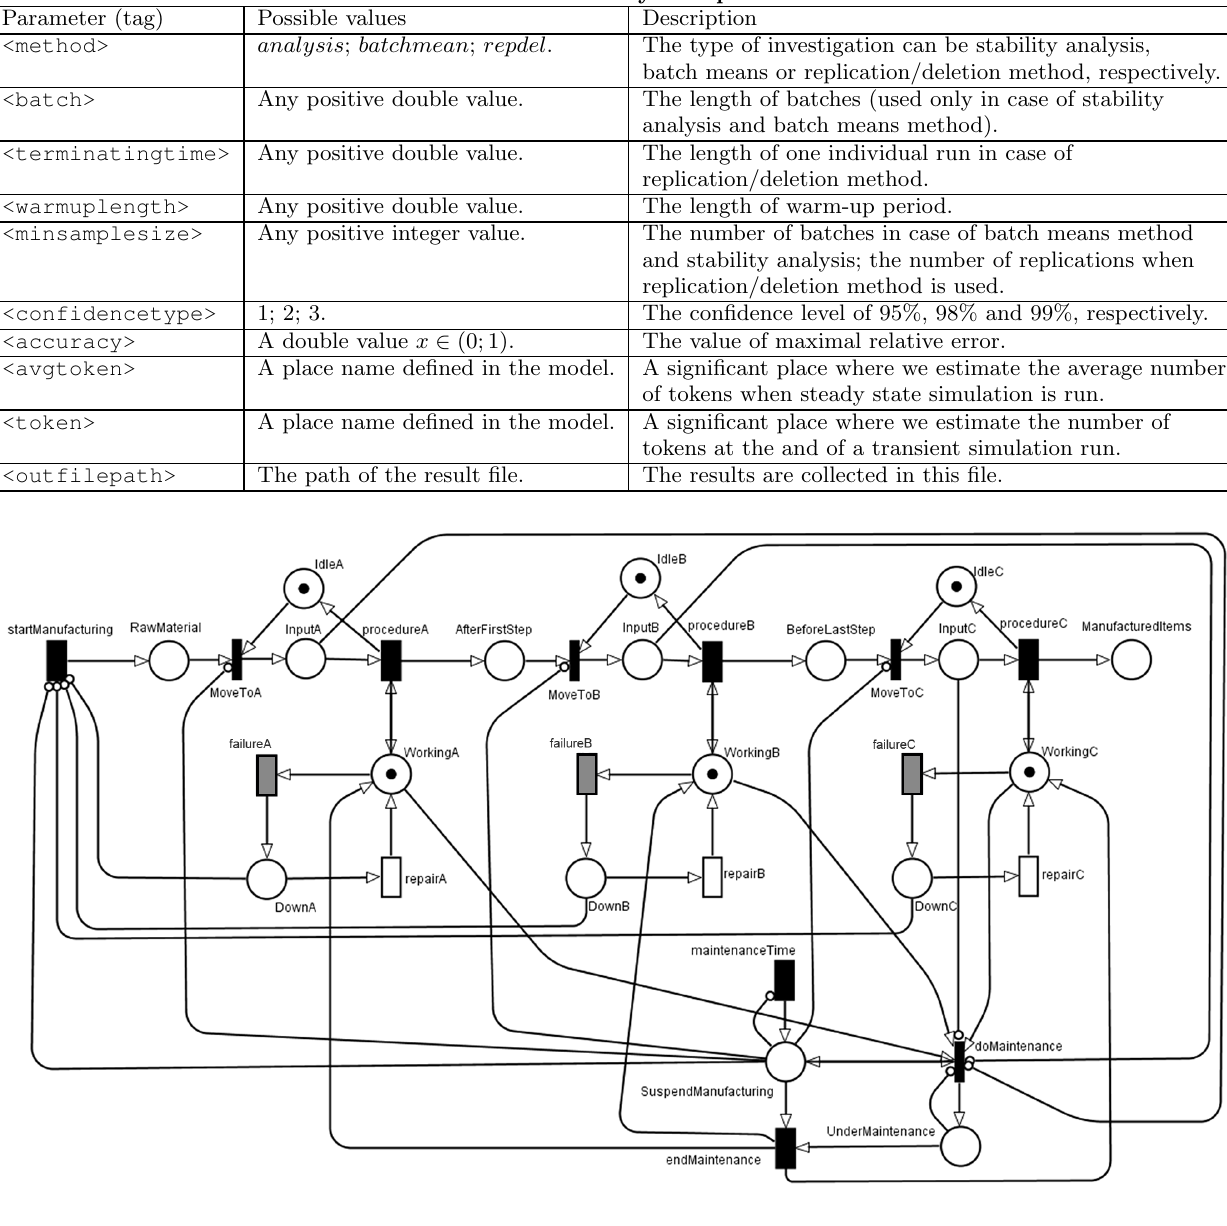
Figure 3: The Petri net model of the sample production line.